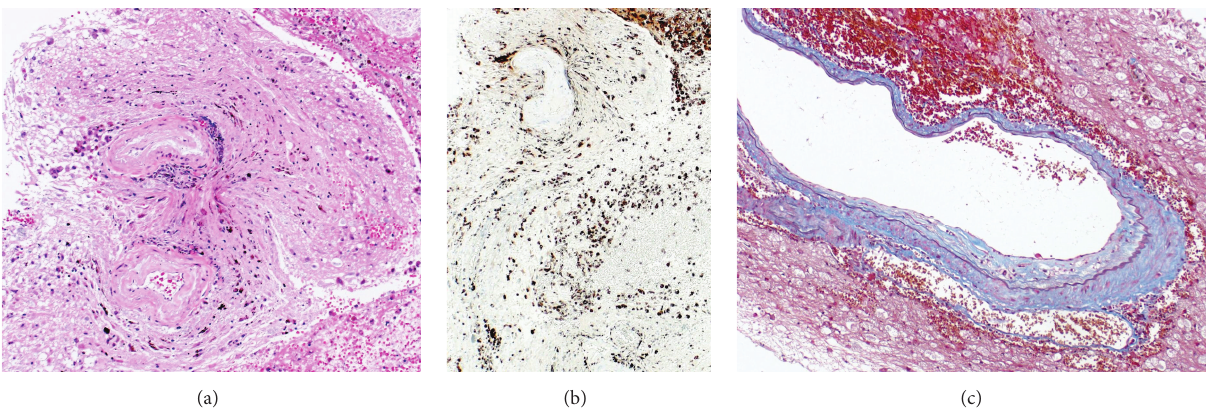
Figure 2: (a) Histological findings reveal hematoma capsule consisting of a dense collagenous layer with extensive invasion of macrophages, hematoxylin and eosin, × 40. (b) Immunohistochemical findings showing numerous CD68-positive cells in the cyst wall, original magnification × 40. (c) Vessel wall is thickened and internal elastica lamina is intact, revealing no residual nidus in the incised cyst wall, Masson, ×